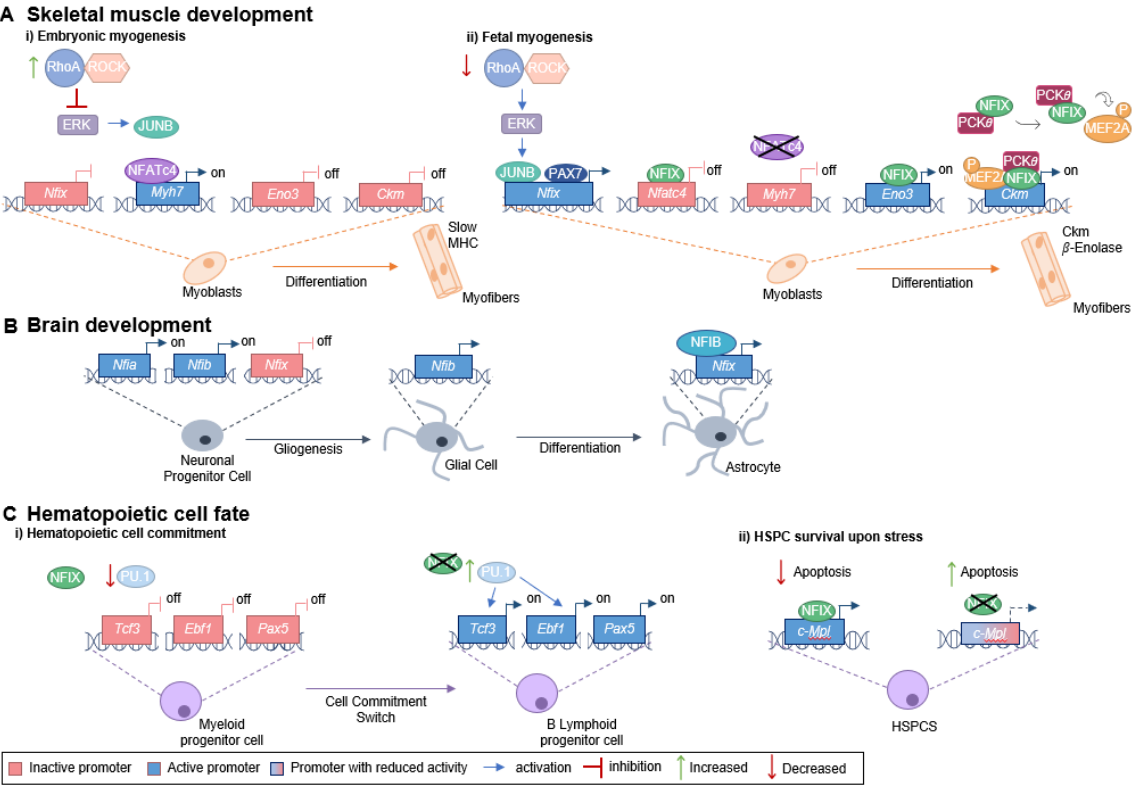
Figure 1. Role of NFIX in development . ( A ) NFIX promotes the switch between embryonic and fetal myogenesis: (i) During embryonic development, embryonic muscle-specific genes are expressed, including Myh7 (encoding slow MHC), which is activated by NFATc4 that binds to the Myh7 promoter. The RhoA/ROCK axis promotes the embryonic identity of myoblasts through the repression of ERK kinases, JUNB and NFIX. (ii) In the transition from embryonic to fetal muscle development, RhoA/ROCK activity decreases, which leads to increased ERK activity and subsequent activation of JUNB. The transcription factor PAX7 also binds to the Nfix promoter activating its transcription. NFIX binds to the Nfatc4 promotor inhibiting Nfatc4 expression and, consequently, slow MHC is not produced. On the other hand, NFIX activates fetal-specific genes, such as Ckm and Eno3 (which encodes β -enolase) , its downstream targets. NFIX binds directly to the Eno3 promoter, activating its transcription, while activation of the Ckm promoter involves a MEF2A/NFIX/PKC θ complex. ( B ) Glial cell differentiation is promoted by NFIX: the expression of Nfia and Nfib by neuronal progenitor cells leads to a gliogenic switch. Then, NFIB binds the Nfix promoter region activating its transcription, and, in its turn, NFIX activates the astrocytic genes leading to astrocyte